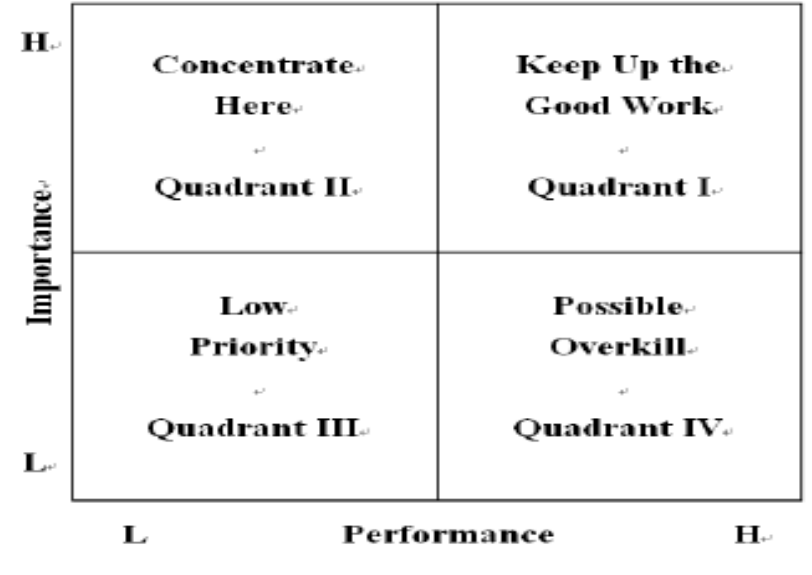
Gambar B.1 grafik model Importance-Performance